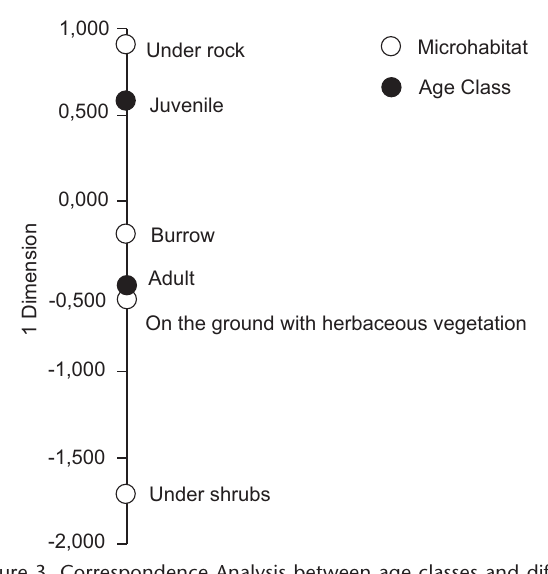
Figure 3. Correspondence Analysis between age classes and dif- ferent microhabitats used by C. vacariensis in the study area,municipality of Bom Jesus between October 2006 and Sep- tember 2007.